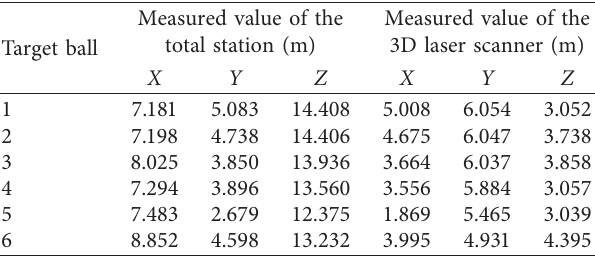
Table 4: The real coordinate of the test target. Target